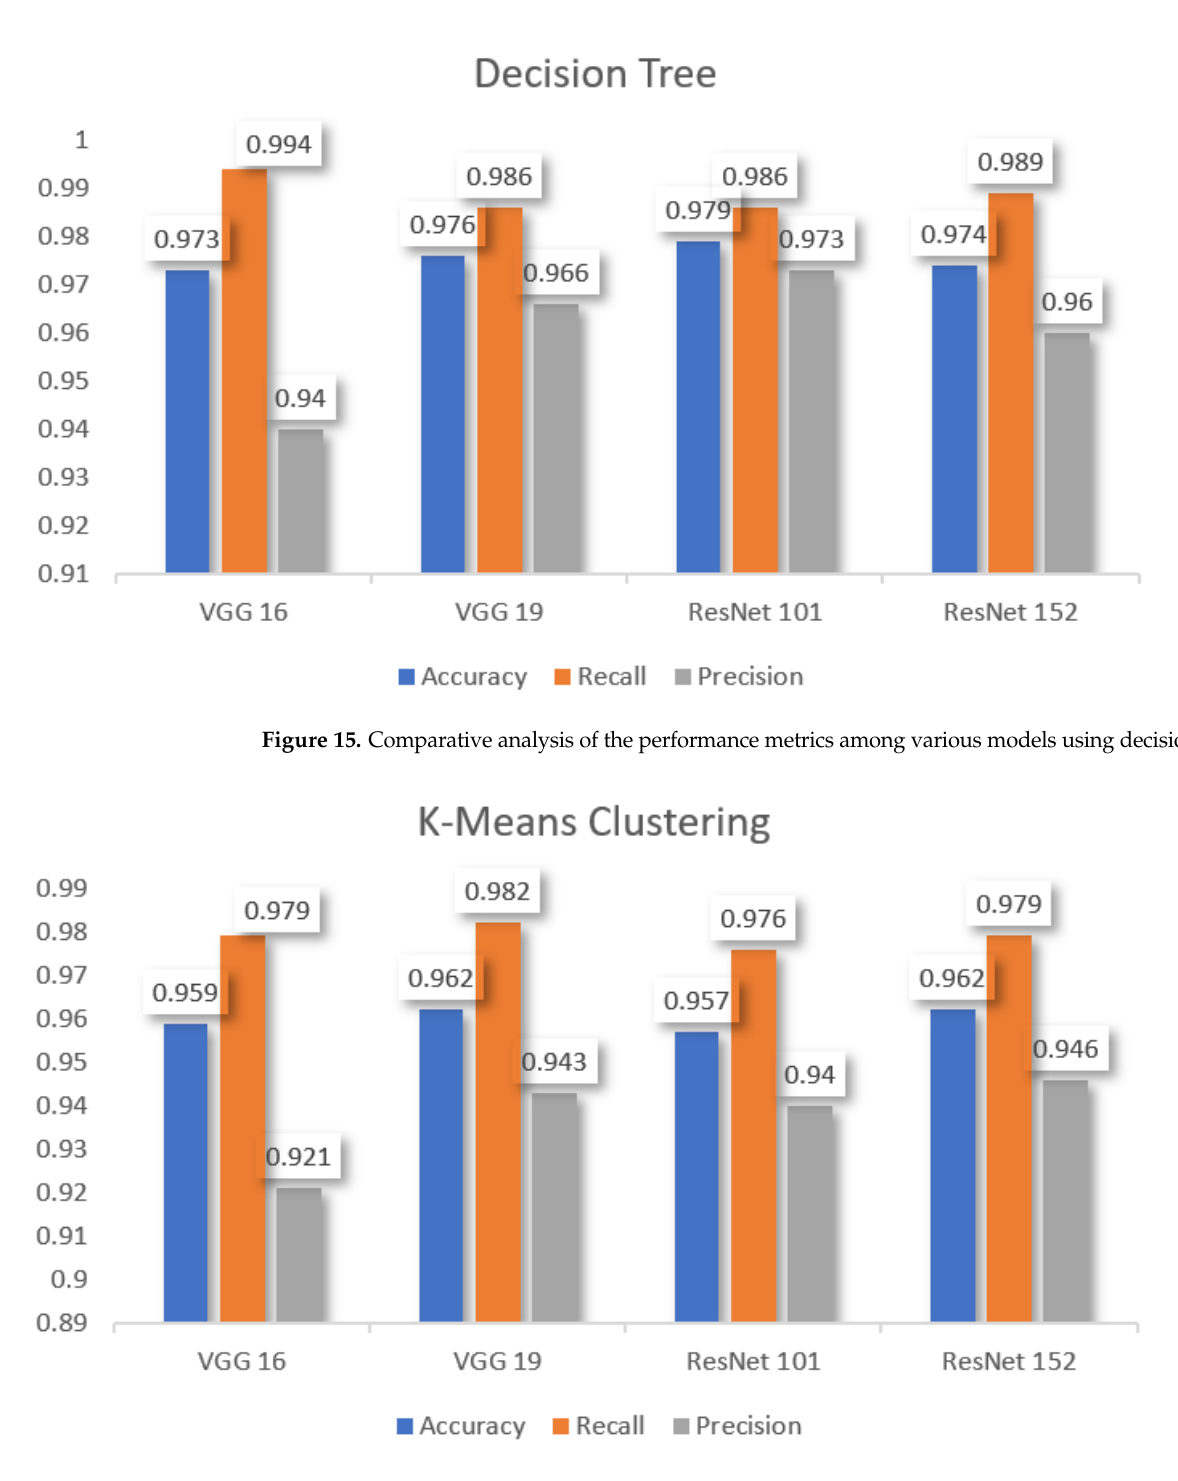
Figure 14. Comparative analysis of the performance metrics among various models using k -nearest neighbor (KNN).